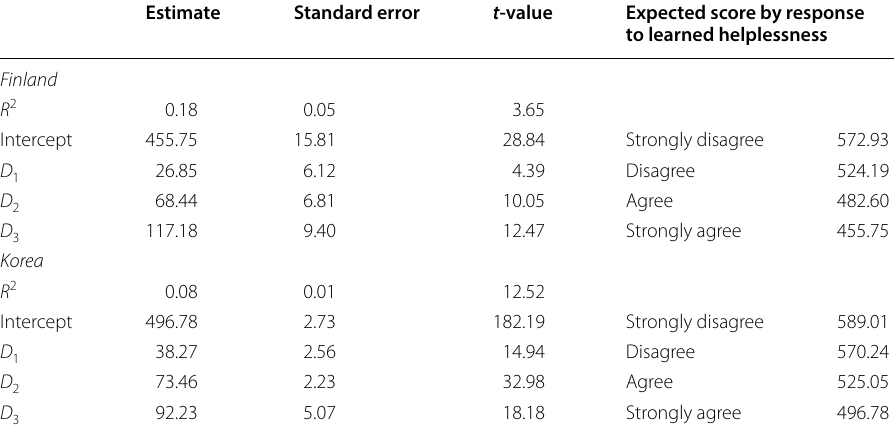
Table 8 Linear regression analysis results and expected scores of each category of learned helpless Estimate Standard error t -value Expected score by response